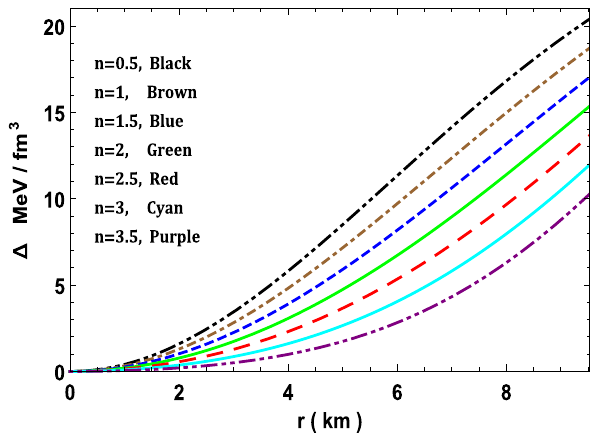
Fig. 4 Variation of anisotropy with radial coordinate r for 4U 1608- 52 ( M = 1 . 74 M (cid:9) , R = 9 . 528 km) by taking a = 0 . 001 km − 2 and β = 0 .